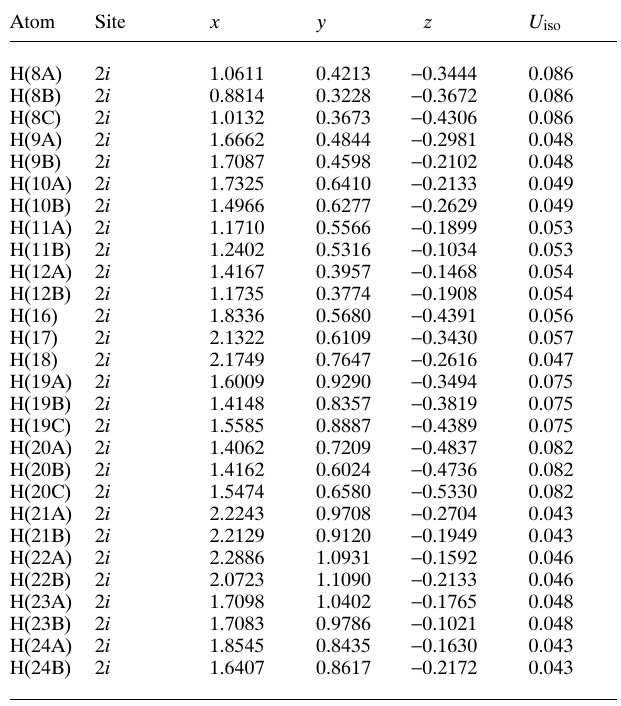
Table 1. Data collection and